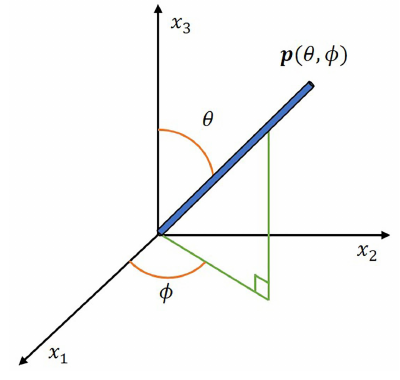
Figure 7. Unit vector